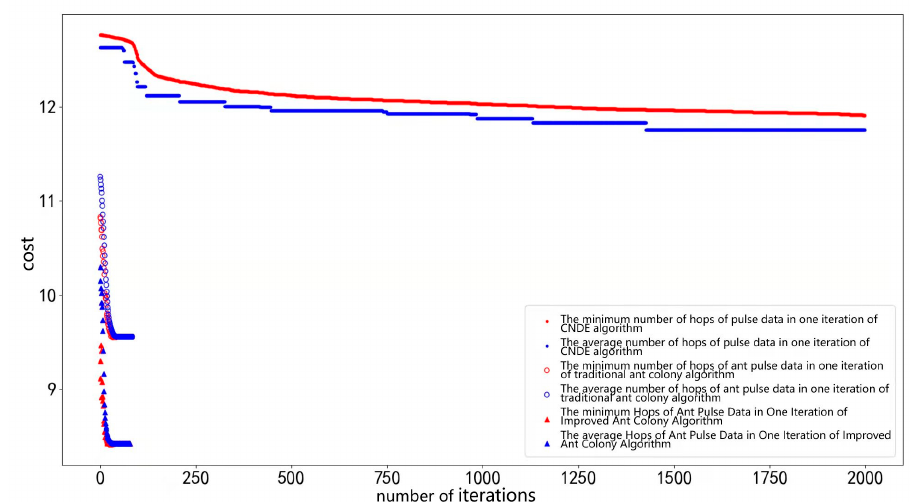
Figure 4. Cost of the ant colony algorithm and CNDE mapping varies with the number of iterations.